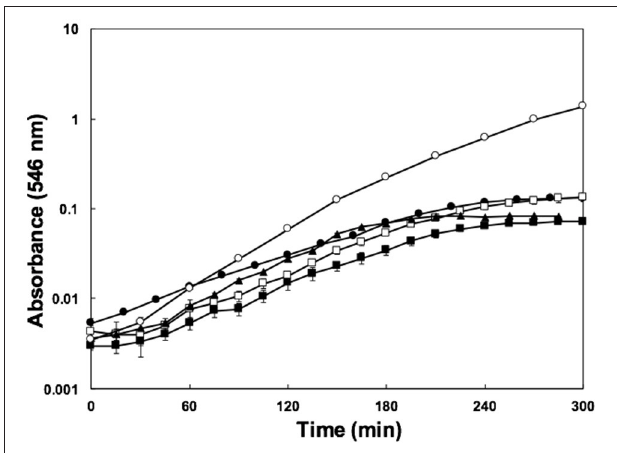
FIGURE 1 | Growth of E. coli 0157:H7 933D stxII- in SESOM from deciduous forest soil ( ), corn field soil ( ), corn field soil supplemented with 10% (m/v) cow manure ( ), garden soil ( ), and LB broth ( ) while shaking at 30 ◦